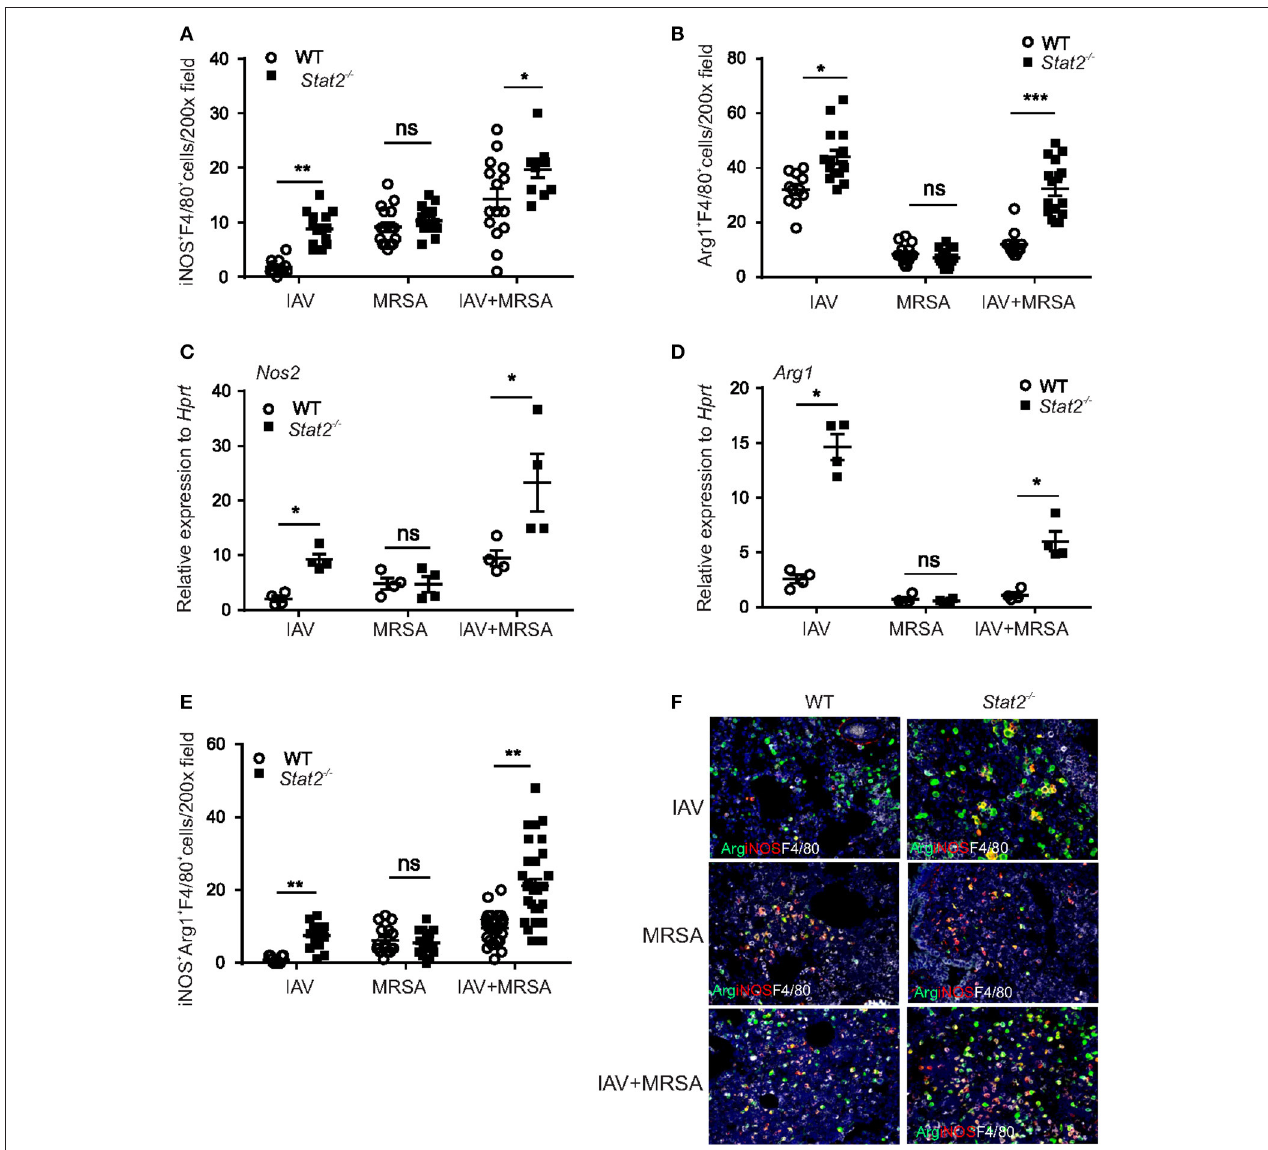
FIGURE 5 | Increased M1 and M2 macrophage expression in Stat2 − / − is dependent on influenza but not MRSA infection. WT or Stat2 − / − mice were infected with 100 PFU of influenza for 6 days or 5 × 10 7 cfu of MRSA for one day or super-infection as described in methods. (A) iNOS + F4/80 + , N = 11–16 (B) Arg1 + F4/80 + producing cells were determined from lungs by IHC, N = 11–16. (C) Nos2 , (D) Arg1 gene expression was analyzed from lungs by RT-PCR, N = 4 per group. (E) iNOS + Arg1 + F4/80 + producing cells were determined from lung by immunohistochemistry, N = 11–32 per group. (F) Representative figures, × 200 magnification fields are shown. Data are represented as mean ± SEM. Data analyzed using two-tailed Student’s t -test, * p < 0.05, ** p < 0.01, *** p < 0.001, ns, not